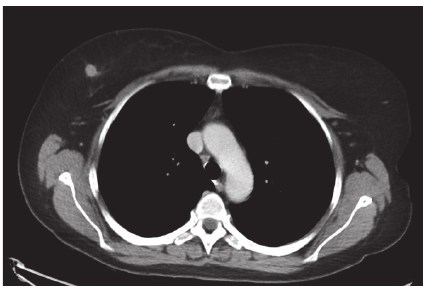
Figure 1: CT scan of the chest at the time of diagnosis demonstrated a round, hyperintense, 1.0cm lesion in the upper outer quadrant of the right breast.